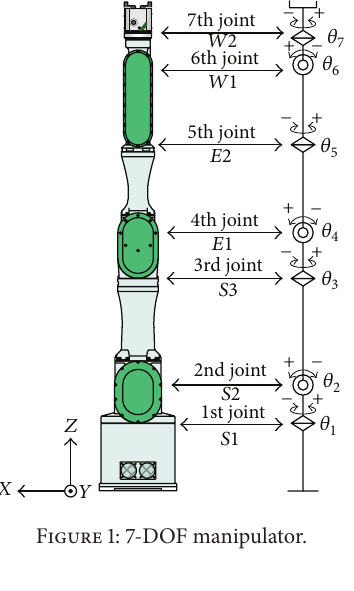
Figure 1: 7-DOF manipulator.